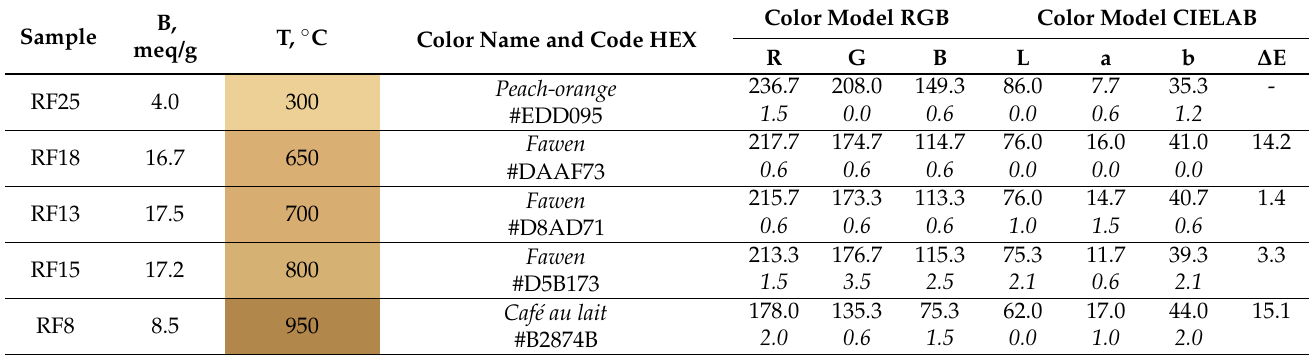
Table 4. Color characteristics of the samples of the RF